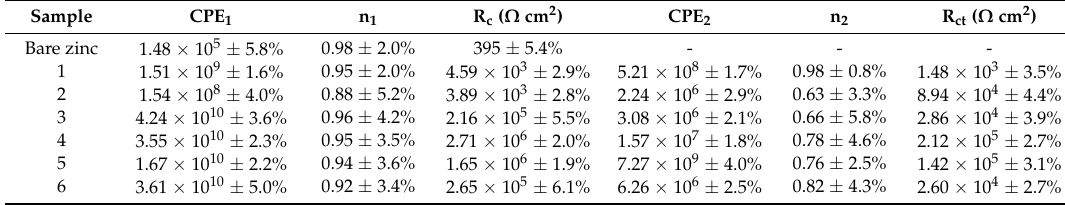
Figure 6. Equivalent circuit model of ( a ) uncoated zinc and ( b ) coated zinc. CPE 1 and CPE 2 are coating film capacitance and its double-layer capacitance in 3.5% NaCl solution, respectively. R s , R c and R ct are solution resistance, coating resistance and charge transfer resistance. Table 2. Impedance data for bare zinc and coated zinc with the composite coatings in 3.5%